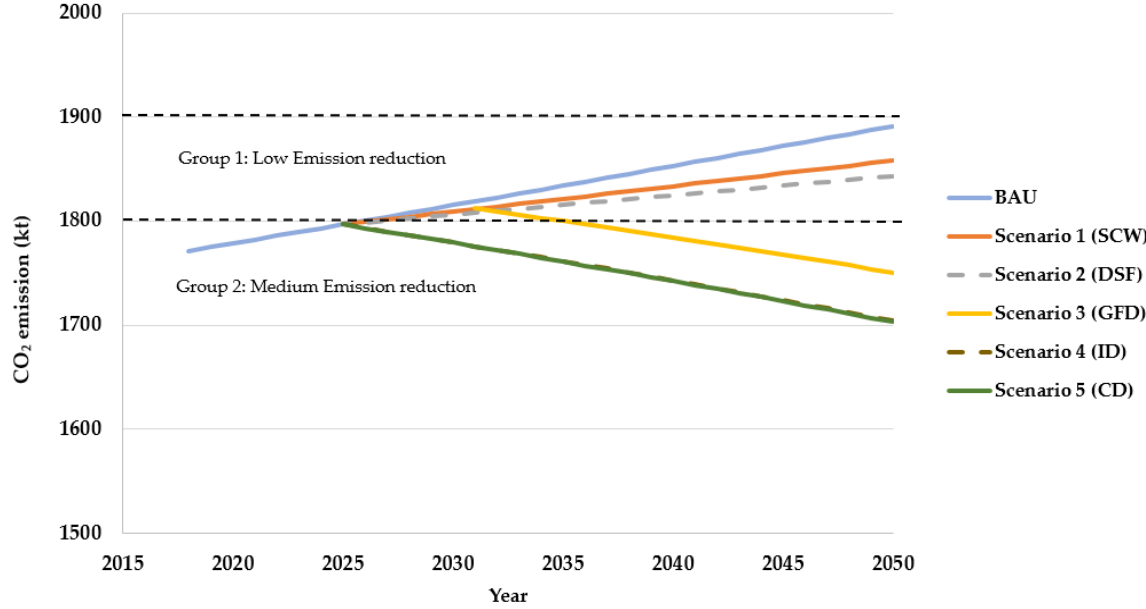
Figure 9. Projection of energy consumption in alternative scenarios compared to the BAU scenario.